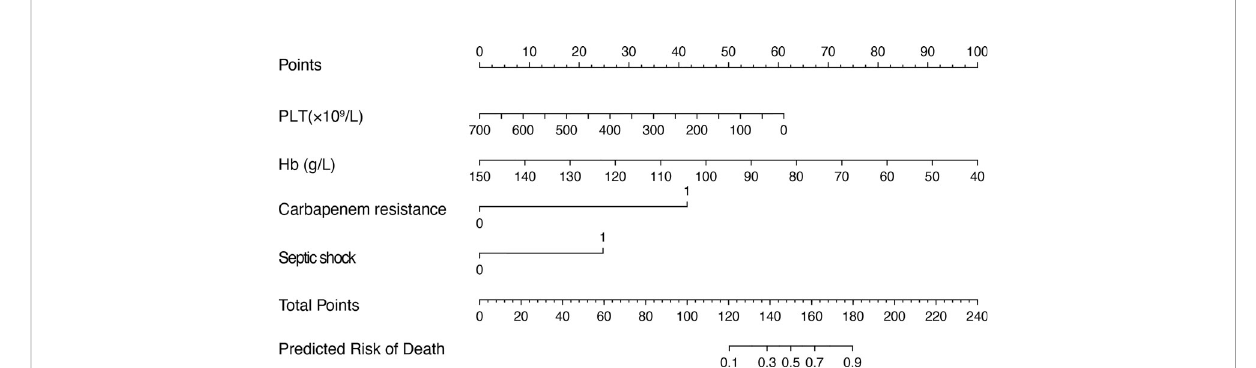
FIGURE 2 Nomogram for predicting the mortality risk in patients with SAP and GNB infection. To evaluate the risk of mortality via the nomogram, draw a line perpendicular to the speci fi c axis of each parameter until it reaches the top line marked “ Points ” , sum up the number of points for all parameters, and draw a line descending from the axis marked “ Total Points ” until it reaches the bottom line to determine the predictive risk of death. PLT, platelet; Hb,